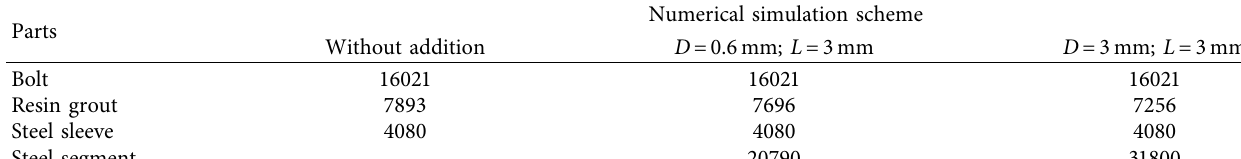
Table 1: Number of mesh elements for different numerical models.